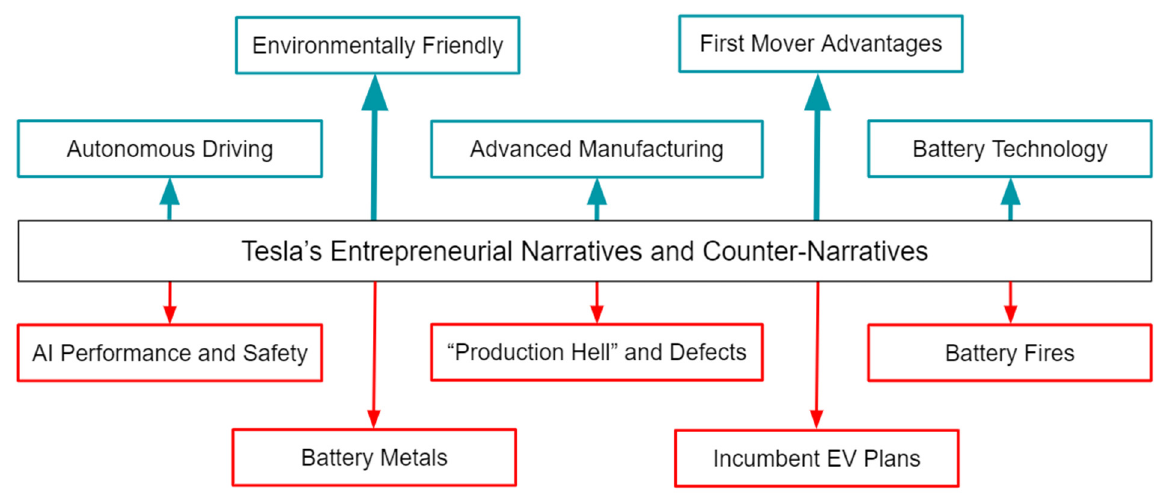
Figure 1. Tesla’s entrepreneurial narratives and associated